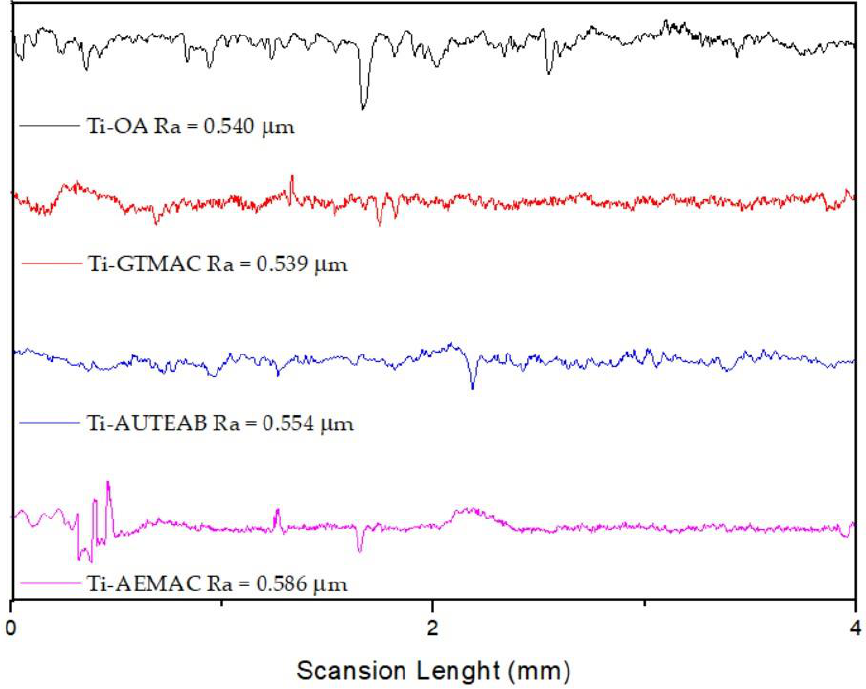
Figure 8. Surface roughness profiles of Ti, Ti-OH, Ti-APTES, and Ti-DAPTES samples.